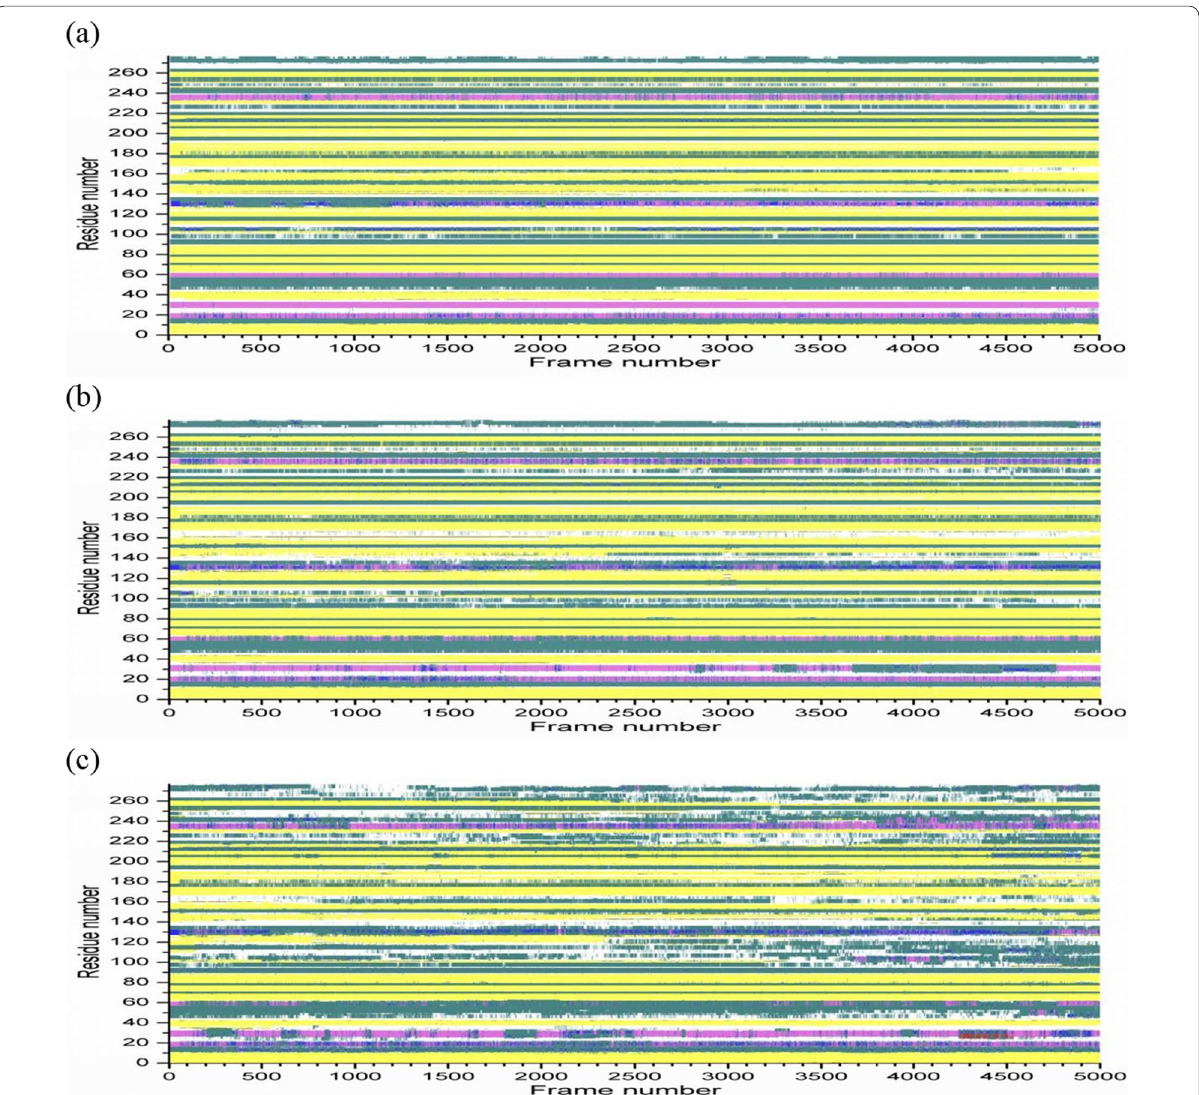
Fig. 5 Secondary structure variations of 3WZ1 at different temperatures. A: 300 K; B: 400 K; C: 500 K. The x-axis shows frame number (trajectory number), the y-axis shows amino acid sequence number. Cyan, yellow, tan, purple, blue, red and white represent the secondary structure of T (Turn), E (β-sheet), B (Isolated bridge), H (Alpha helix), G (3–10 Helix), I (Pi-helix) and C (coil) respectively. Values have been calculated with the use of